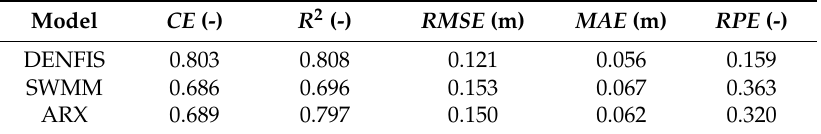
Table 5. CE , R 2 , RMSE , and MAE values for testing river stage time series simulated by DENFIS, SWMM, and ARX models in Dandenong catchment.